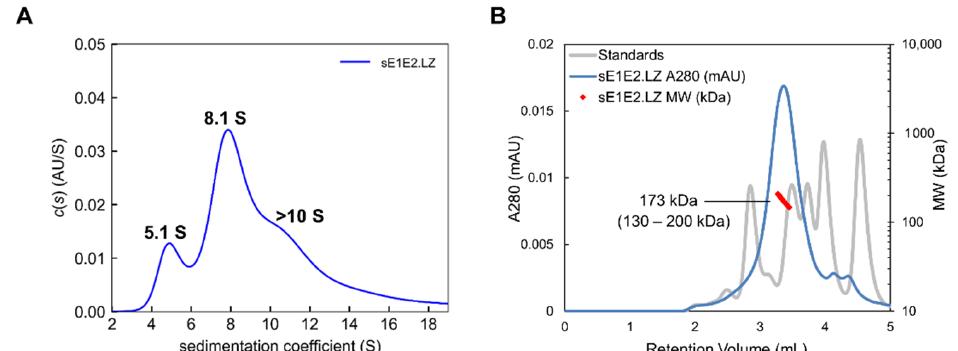
Figure 12. Analytical characterization of sE1E2.LZ heterogeneity. ( A ) AUC profile of purified sE1E2.LZ. Shown is the distribution of Lamm equation solutions c ( s ) for sE1E2.LZ (blue line). Calculated sedimentation coefficients for the peaks are labeled. Observed species for sE1E2.LZ approximately correspond to a heterodimer at 5.1 S, a dimer of heterodimers at 8.1 S, and higher-order aggregates at >10 S. ( B ) sE1E2.LZ characterized with SEC-MALS and compared with molecular weight standards. The SEC-MALS chromatograph of sE1E2.LZ is shown as a blue line. A range of elution volumes within the peak half-maximum is shown as red dots, with the size distribution of each range labeled and enclosed in parentheses. An estimation of molecular weight at the center of each peak is indicated. Molecular weight standards are shown as a grey line corresponding to values of 670, 158, 44, 17, and 1.35 kDa. Reproduced with permission from [22]. Table 2. Binding affinity of mbE1E2, sE1E2.LZ, and sE2 to a panel of monoclonal antibodies measured by dose- dependent ELISA. 1